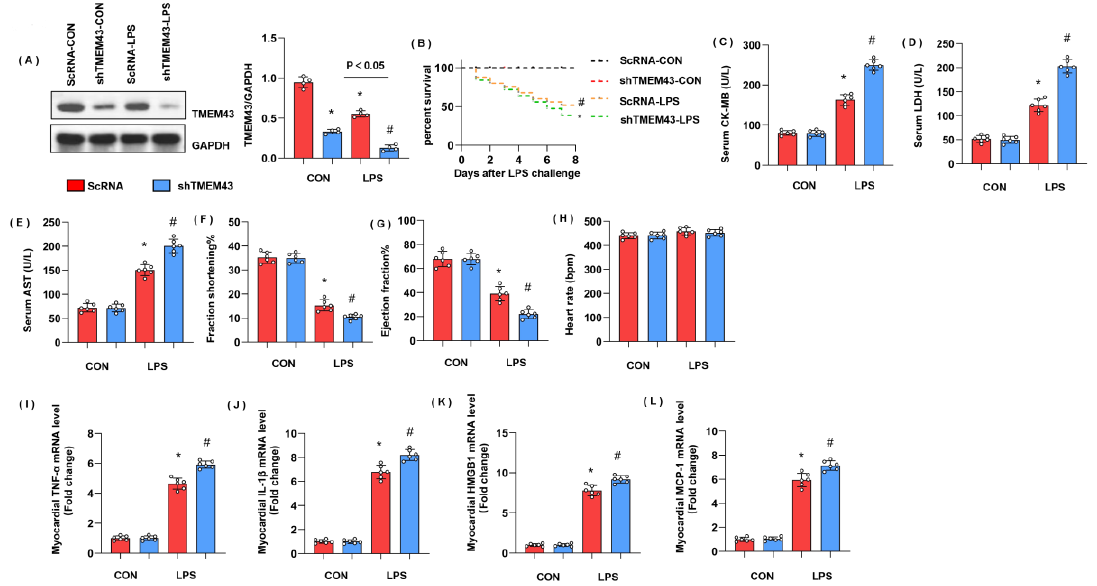
Figure 3. TMEM43 knockdown aggravates LPS-induced cardiac injury. ( A ) Protein level of TMEM43 in mouse hearts injected with shTMEM43 ( n = 4). ( B ) Survival rate of mice in each group ( n = 25). ( C – E ) Serum CK-MB, LDH, and AST in each group ( n = 6). ( F – H ) Echocardiography result in each group ( n = 6). ( I – L ) mRNA level of pro-inflammatory factors in heart tissue under LPS challenge ( n = 6). * p < 0.05 vs. scRNA/CON group. # p < 0.05 vs. scRNA/LPS group.